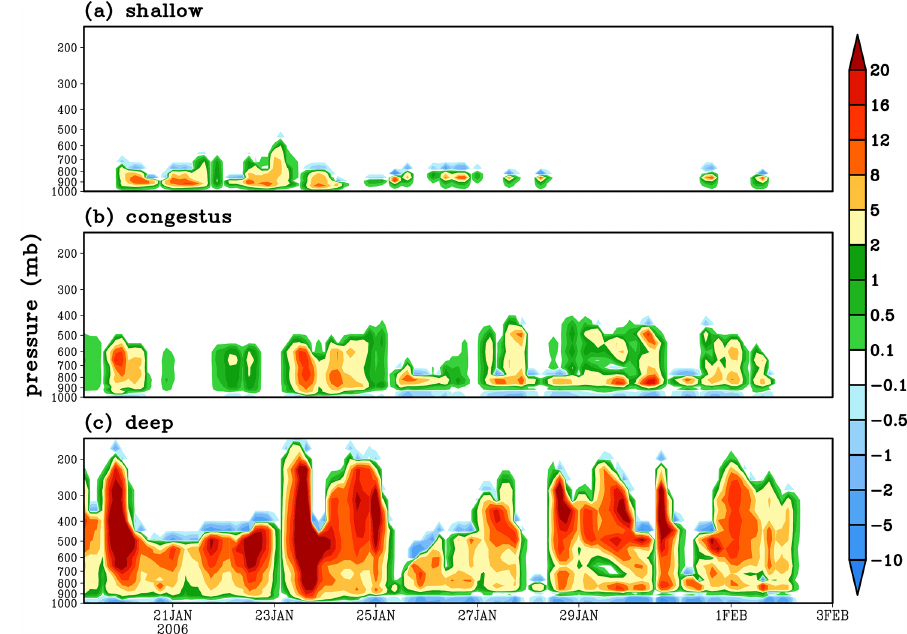
Figure 5. Convective heating tendencies (Kd − 1 ) of (a) shallow, (b) congestus, and (c) deep convection with the GF scheme using the TWP-ICE